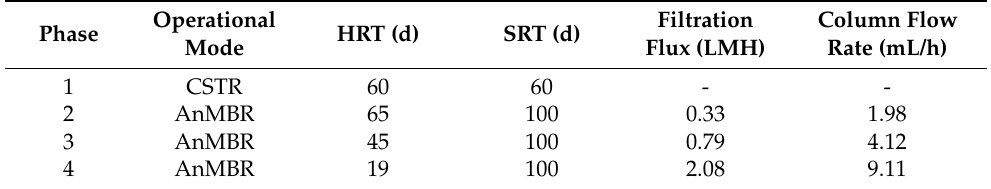
Table 1. Operational conditions of each phase of reactor operation. Phase